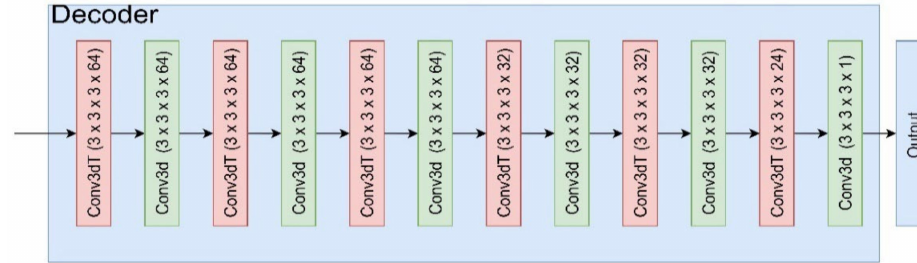
Figure 7. Structure of mixed-multiple convolution